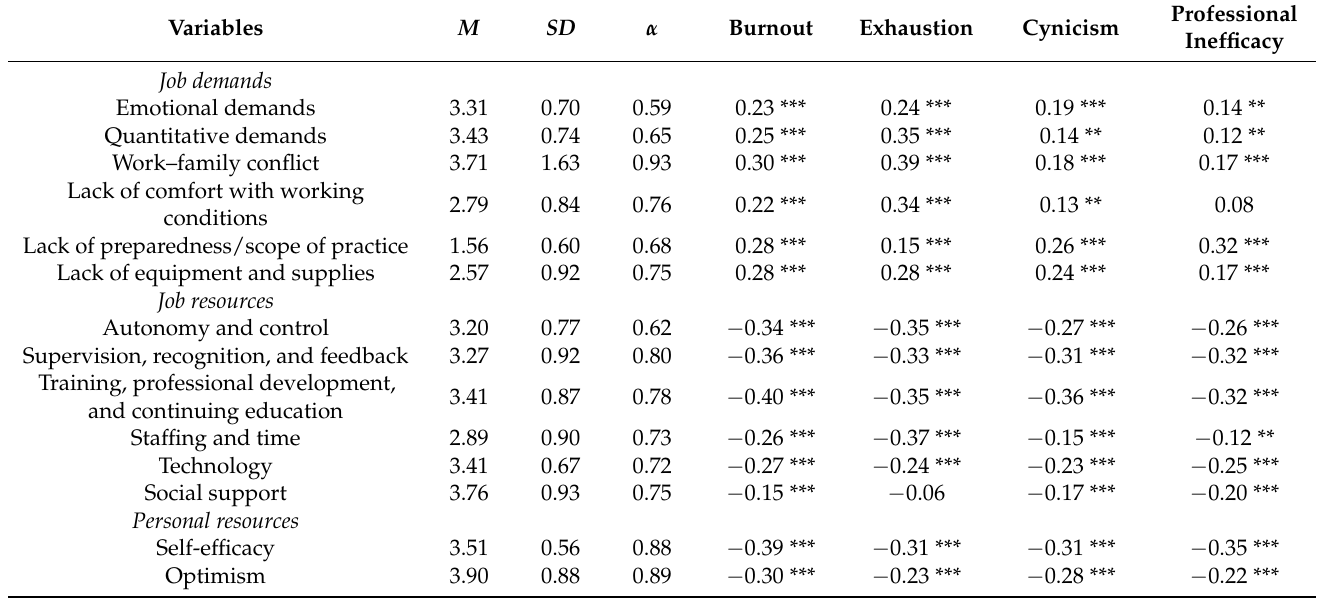
Table 2. Means, standard deviations, reliabilities, and correlations with burnout ( n = 523).